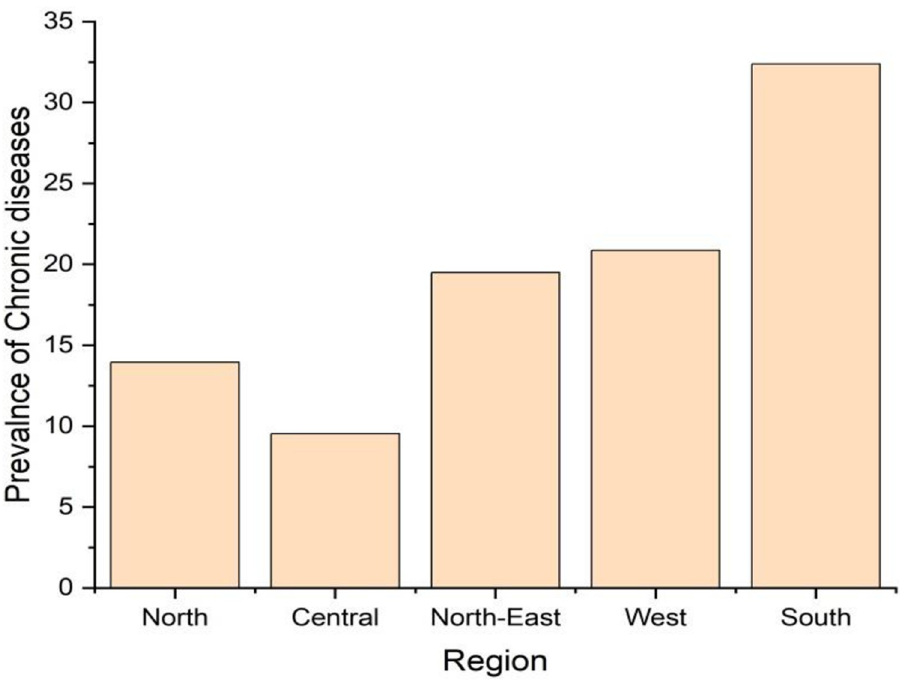
Fig 3. Region wise prevalence of chronic diseases among elderly in India, 2017–18 (based on 75 th round of NSS).